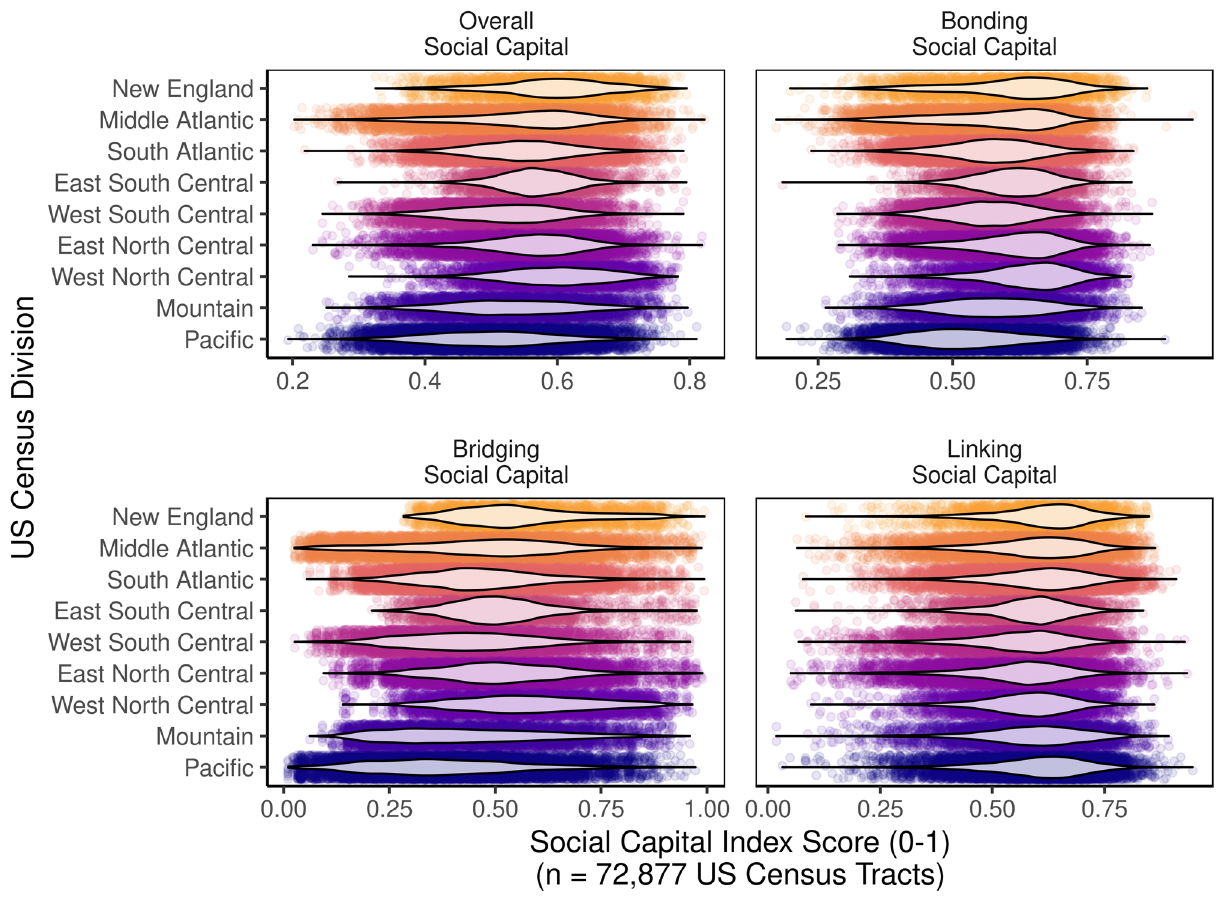
Figure 1. Geographic distribution of social capital indices at the census-tract level. Violins depict distributions of social capital indices for each of the 9 US Census-bureau designated geographic divisions in the